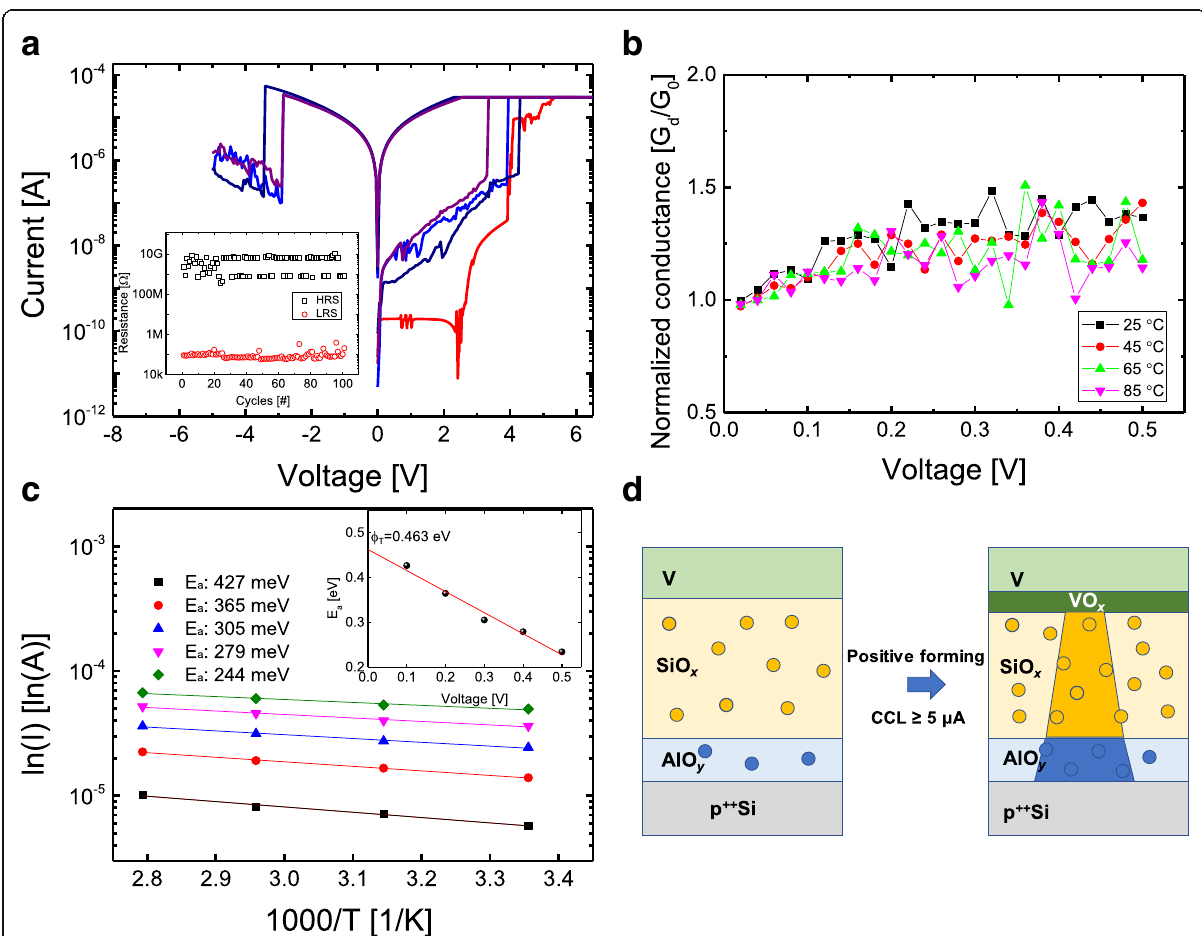
Fig. 3 Memory switching of V/SiO x /AlO y /p ++ Si when a positive forming with CCL of 30 μ A is applied. a Typical I – V curves. b Normalized conductance. c In (I) versus 1000/T. d Schematic drawing of forming